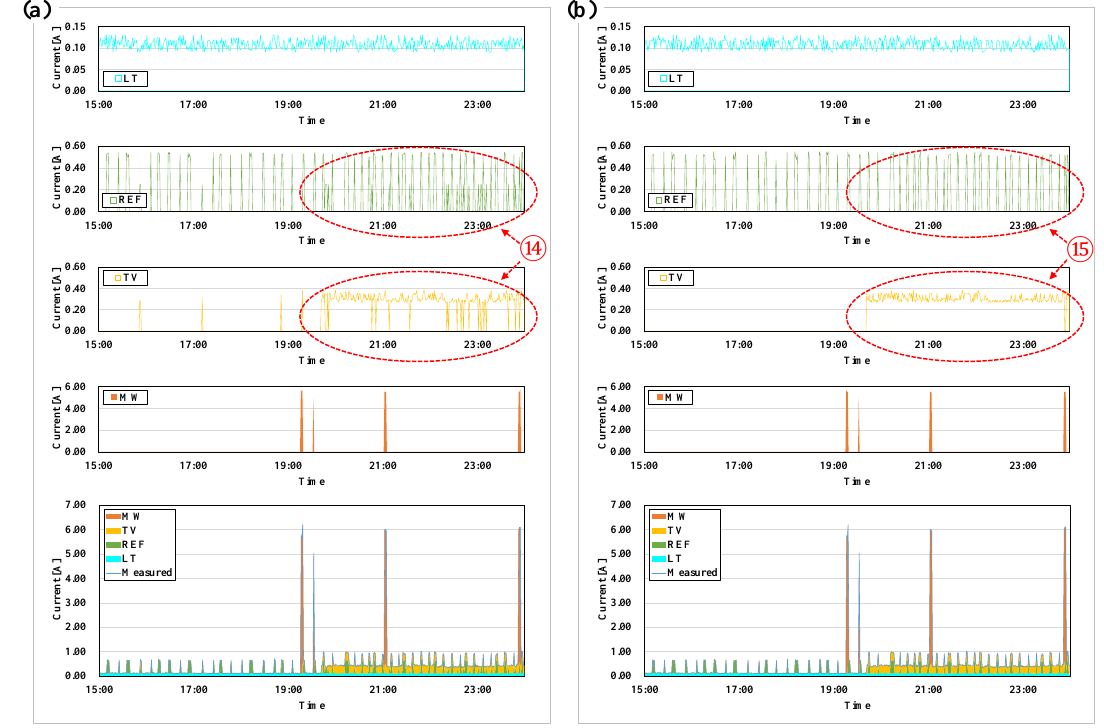
Figure 10. LT + REF usage pattern in terms of load disaggregation outcomes: ( a ) before modification and ( b ) after modification.